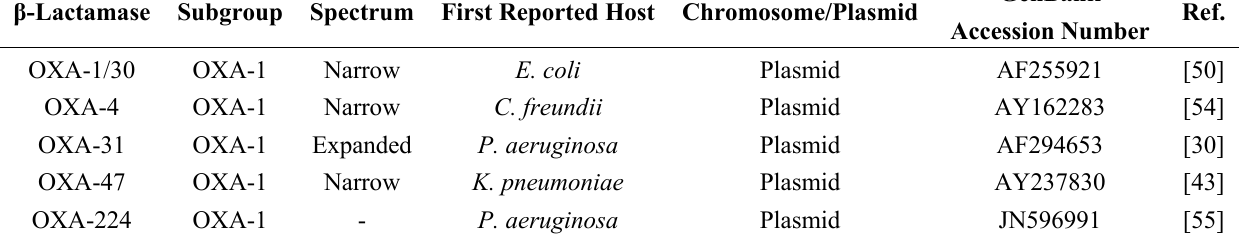
Table 7. OXA-1 like